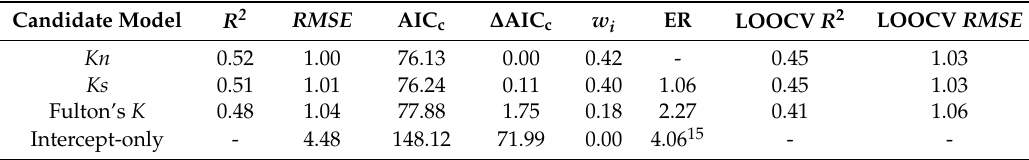
Figure 3. regressions of percent lipid and selected indirect condition indices for juvenile Cottus cognatus ( n = 25), specifically: ( a ) = Fulton’s condition factor (Fulton’s K ); ( b ) = Fulton’s condition factor excluding stomach content and gonadal mass ( Ks ); and ( c ) = Le Cren’s relative condition factor ( Kn ). Solid lines represent linear regression lines; dotted lines denote 95% prediction intervals; and dashed lines denote 95% confidence intervals. Table 4. models ranked to estimate which indirect condition index best approximates percent lipid in juvenile Cottus cognatus ( n = 25). PL = percent lipid; Fulton’s K = Fulton’s condition factor; Ks = Fulton’s condition factor excluding stomach content and gonadal mass; Kn = Le Cren’s relative condition factor; R 2 = coe ffi cient of determination; RMSE = root mean square error of the regression; AIC c = bias-adjusted Akaike Information Criterion for small sample sizes; ∆ AIC c = AIC c of alternative model minus that of the top model; w i = Akaike weight; ER = evidence ratio); LOOCV R 2 = coe ffi cient of determination from cross-validation; LOOCV RMSE = root mean square error from cross-validation. The coe ffi cients of each predictor were significantly di ff erent from 0 ( p = <